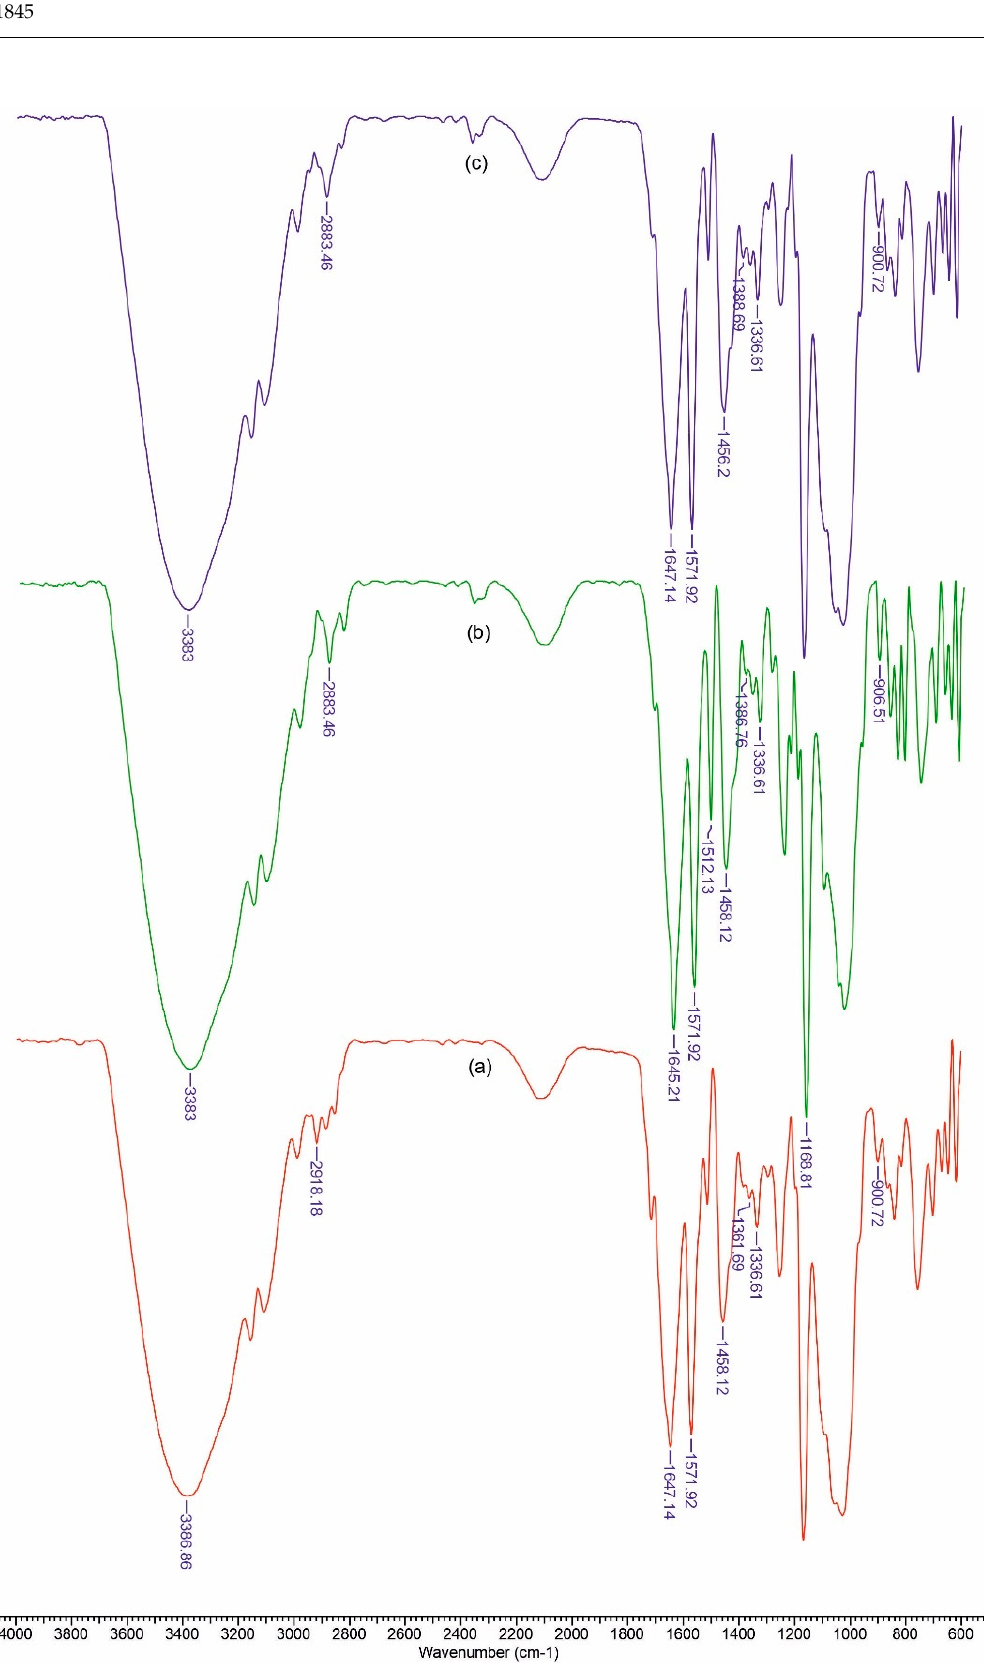
Figure 2. FTIR spectra for CCPK ( a ), CCPOLK ( b ) and CCPLMCK ( c ).